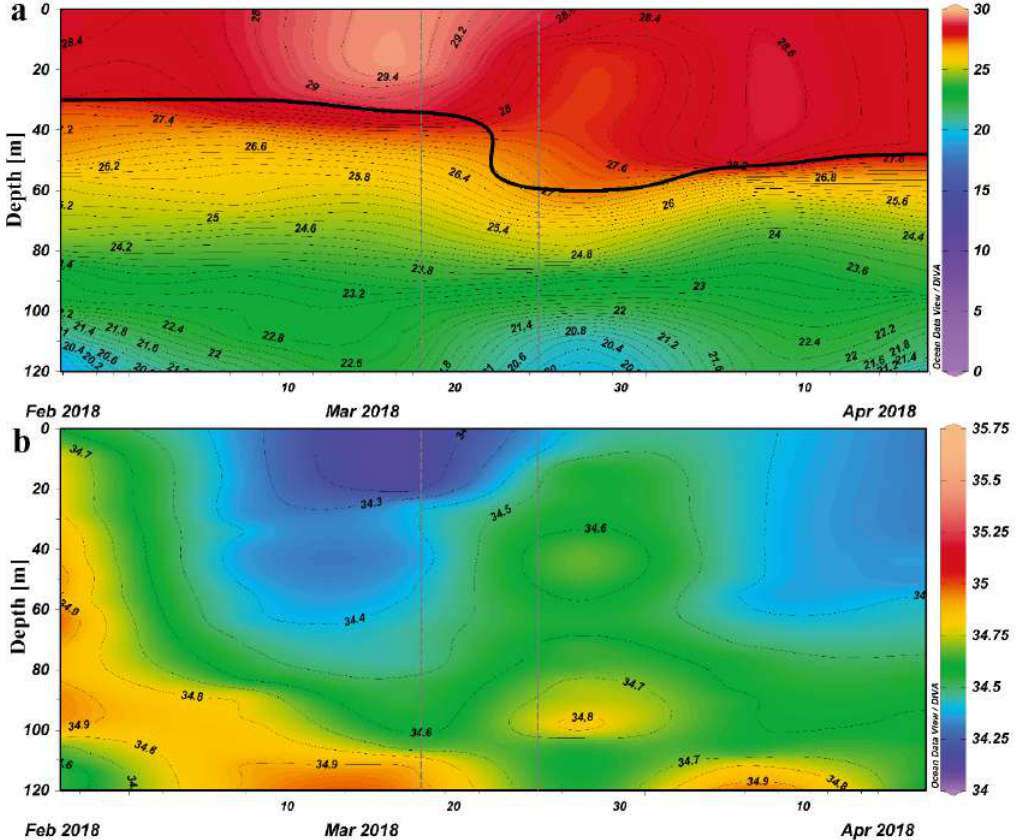
Fig. 4: Vertical profile of temperature (color in °C) (a), and salinity (color in PSU) (b) at Argo Float stations. The thick contour-line in (a) indicates a MLD. A thick vertical dash-line indicates the occurrence of Cyclone Marcus between 18 and 25 March 2018. Data interpolation among the Argo Float stations and visualization was carried out using Ocean Data View with DIVA (Data Interpolating Variational Analysis) method (Schlitzer, 2021)